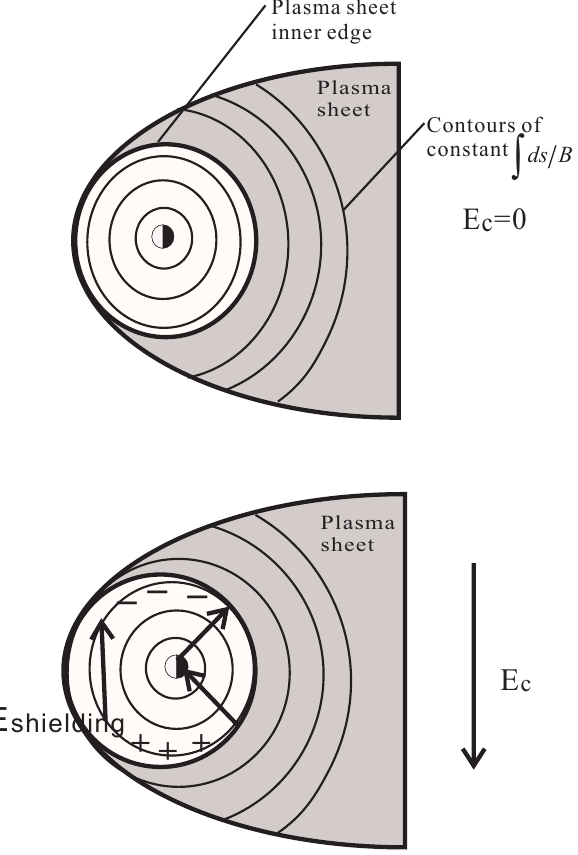
Fig. 3. Illustration of the formation of shielding electric